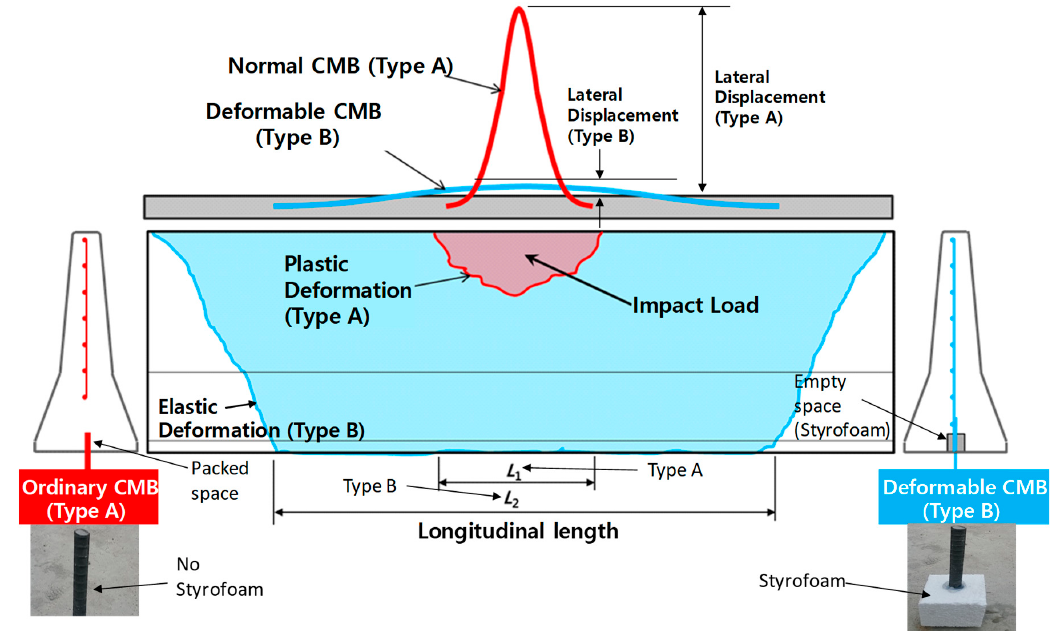
Figure 2. A conceptual drawing for comparison of an ordinary CMB (Type A) with a deformable CMB (Type B).